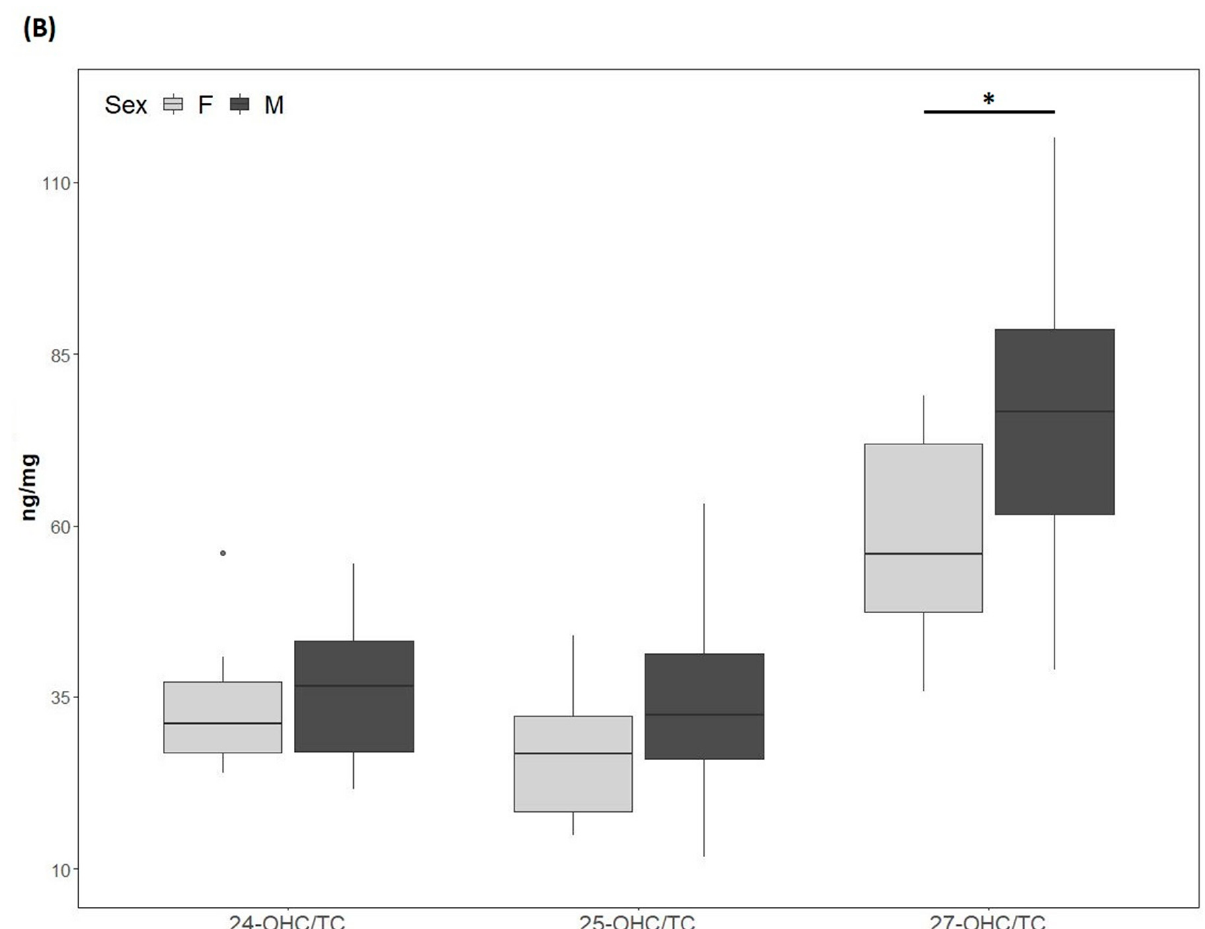
Figure 2. ( A ) 24-hydroxycholesterol (24-OHC), 25-hydroxycholesterol (25-OHC) and 27-hydroxycholesterol (27-OHC) plasma levels; ( B ) 24-OHC/total cholesterol (TC), 25-OHC/TC and 27-OHC/TC. TC values (mean ± SD) were 250.5 ± 75.6 mg/dL for males and 257.9 ± 80 mg/dL for females. M, males; F, females. * p -value < 0.01.